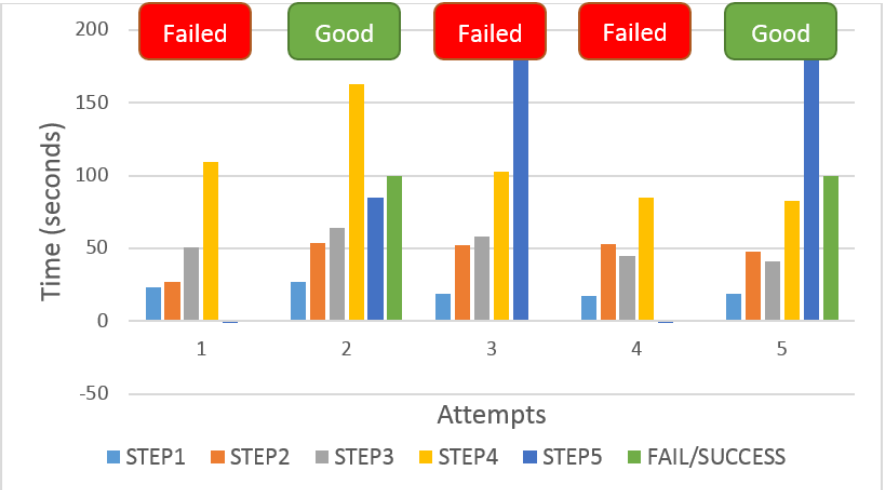
Figure 18. Usability test using 2 operators to teleoperate the team: 3 experiments failed, and 2 succeeded. The failures are due to human operator training ( Y axis represents the intervention